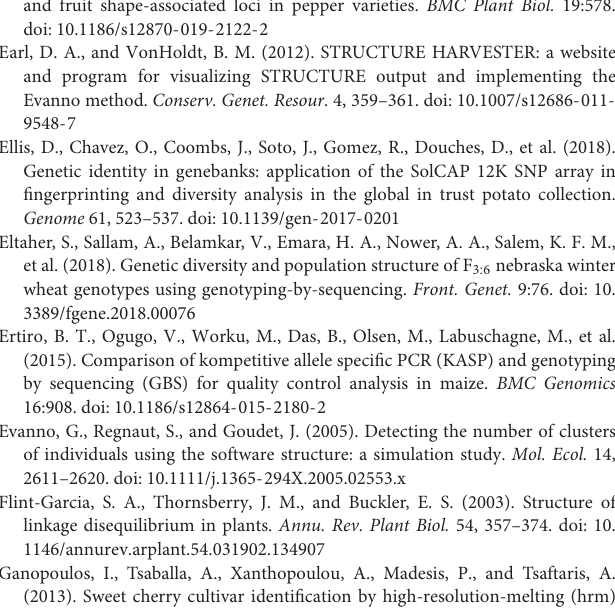
Supplementary Table 8 | Results of pairwise population Fst analysis when K =